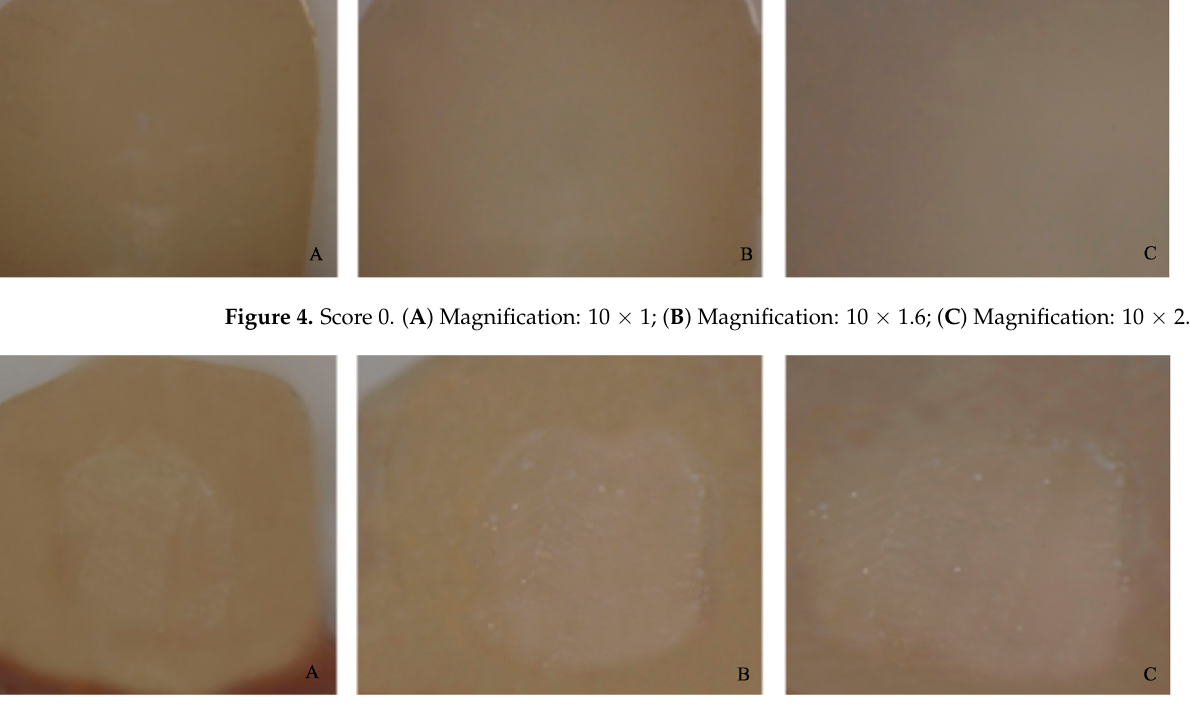
Figure 5. Score 1. ( A ) Magnification: 10 × 1; ( B ) Magnification: 10 × 1.6; ( C ) Magnification: 10 × 2.5.